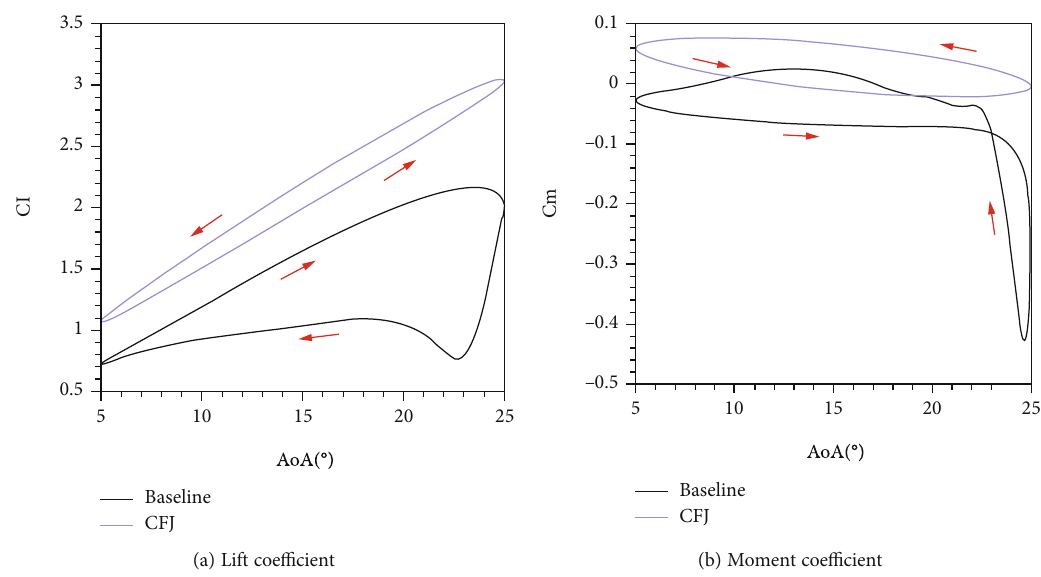
Figure 9: Lift and moment coe ffi cient distributions of the OA212 baseline and CFJ